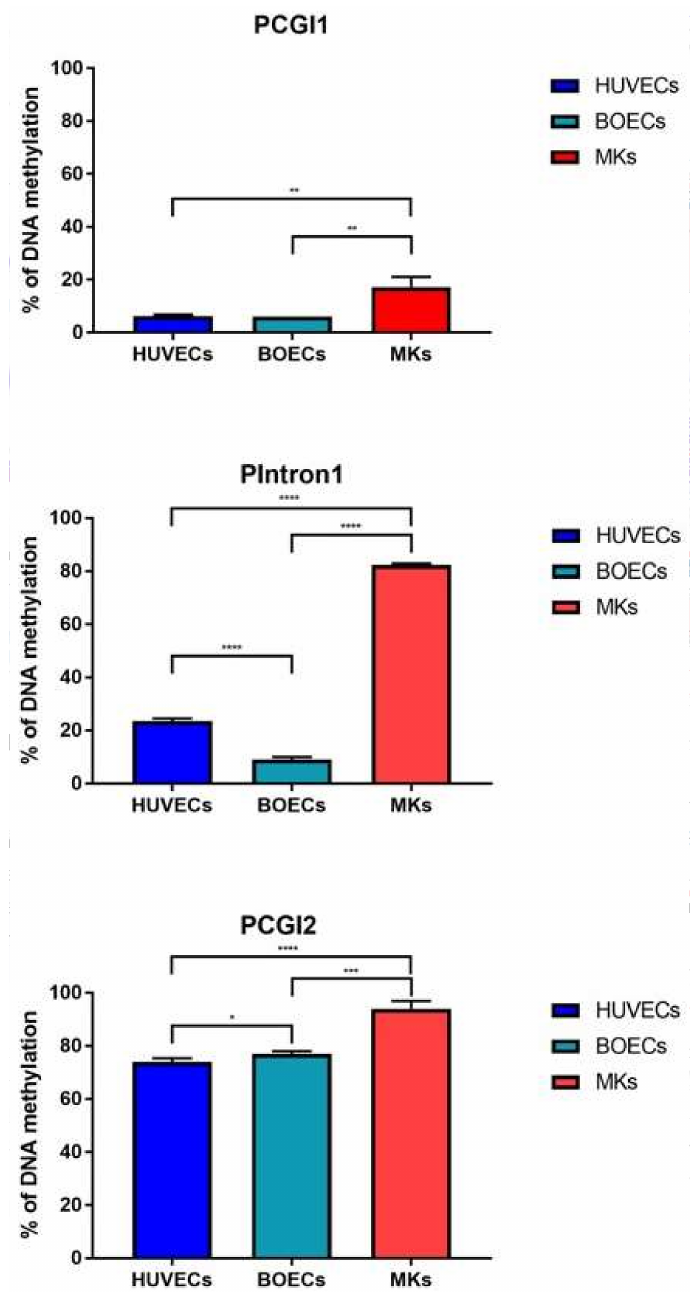
Figure 2. PEAR1 DNA methylation is higher in megakaryocyte precursors than in HUVECS or Blood Outgrowth Endothelial cells (BOECs). PEAR1 methylation profile in HUVECs, BOECs and Megakaryocytes (MK) precursors (indicated as “MKs”) analysed on at least 3 biological replicates (data reported as mean +/ − SD). * p < 0.05, ** p < 0.001, *** p < 0.0001, **** p < 0.00001, unpaired t